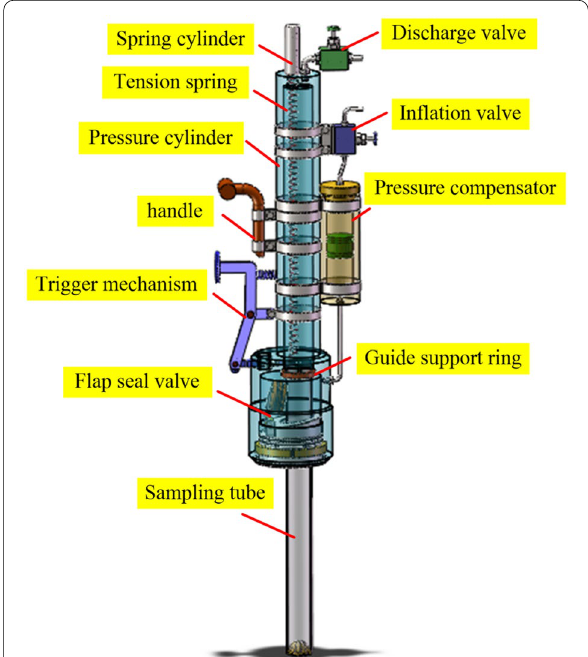
Figure 1 Three-dimensional map of the GTSS